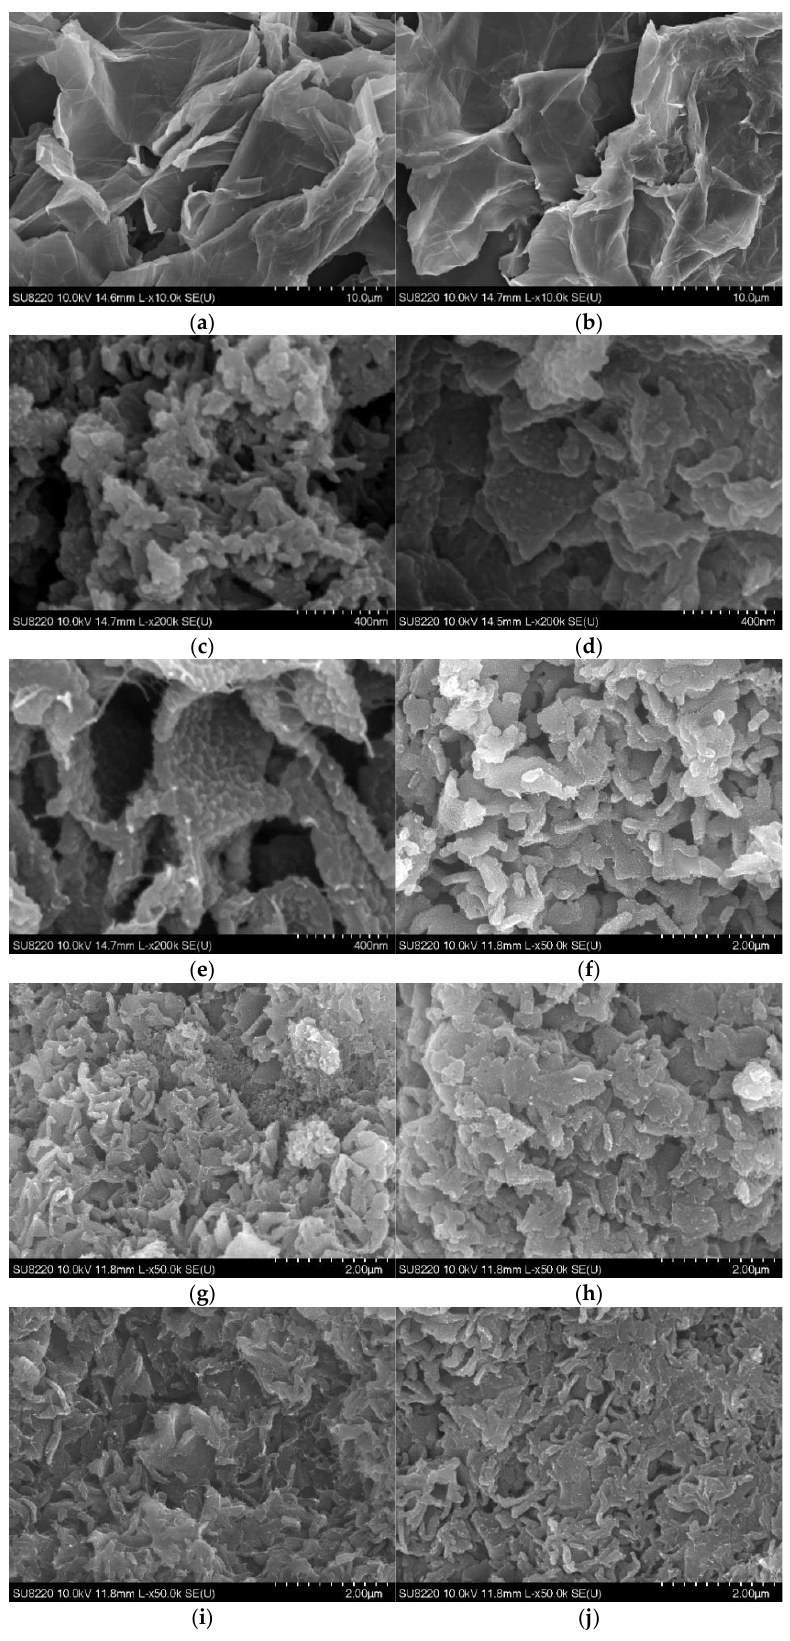
Figure 1. SEM images of GO ( a ), CGO ( b ), PANI ( c ), GO/PANI-3 ( d ), CGO/PANI-1 ( f ), CGO/PANI-2 ( g ), CGO/PANI-3 ( e,h ), CGO/PANI-4 ( i ), and CGO/PANI-5 ( j ).